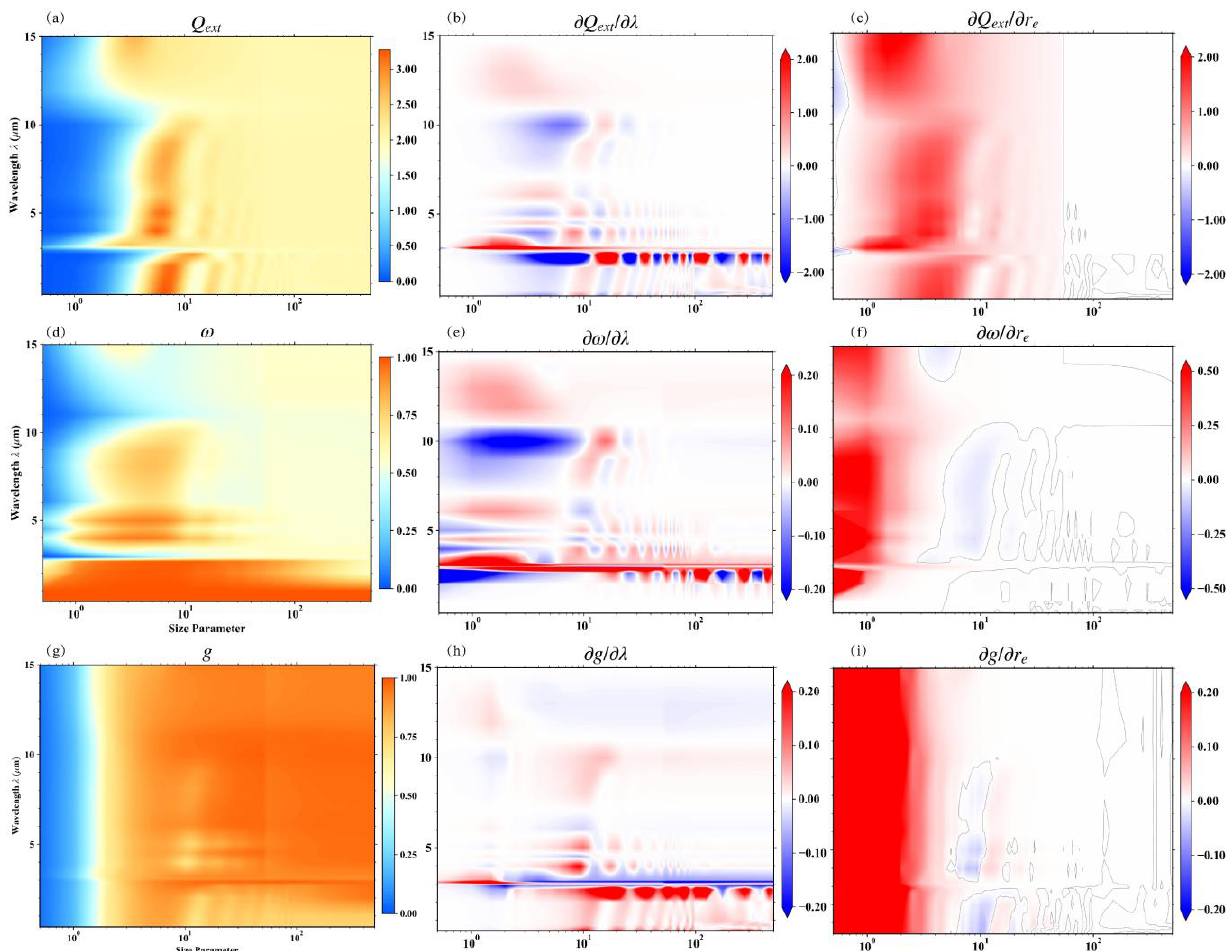
Figure 5. Trends in integral scattering properties and their partial derivatives with respect to wave- length and effective radius for wavelengths of 0.4–15 µ m and size parameters of 0.5–500. Nine diagrams correspond to extinction efficiency Q ext ( a ), single scattering albedo ω ( d ), and asymmetry factor g ( g ) and their Jacobians with respect to the wavelength ( b , e , h ) and effective radius ( c , f , i ). Dashed lines in the third column represent the division of positive and negative